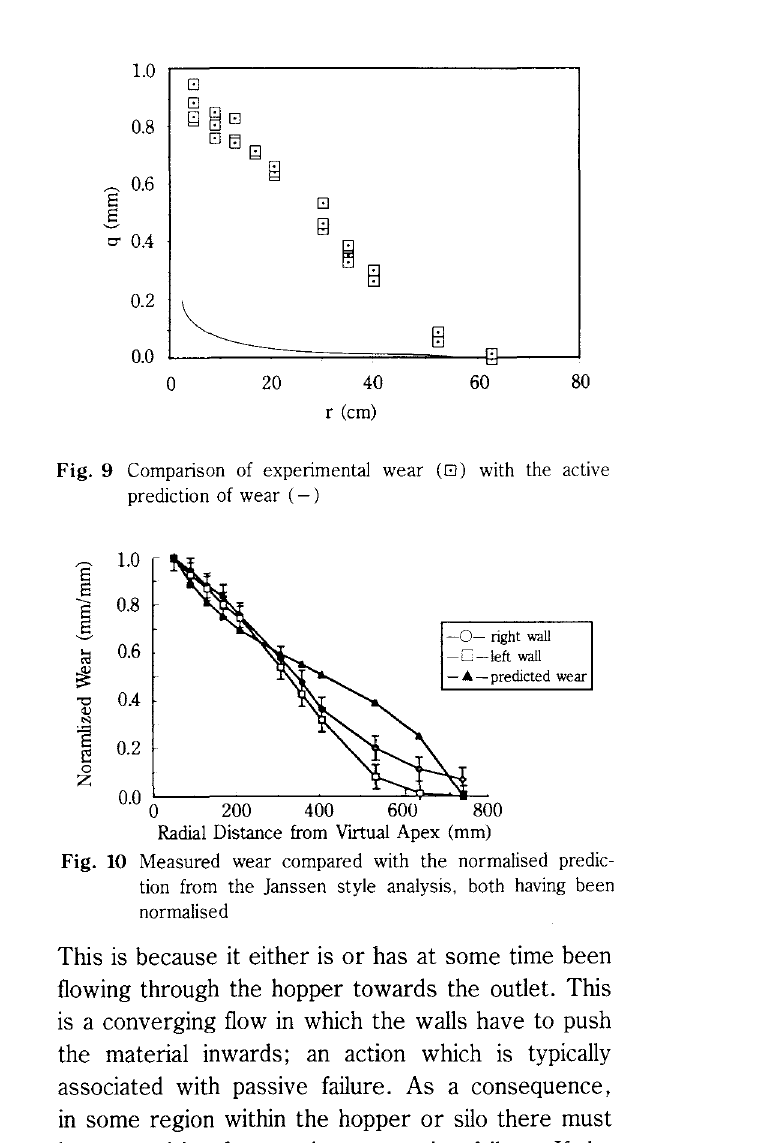
Fig. 10 Measured wear compared with the normalised predic tion from the Janssen style analysis. both having been normalised